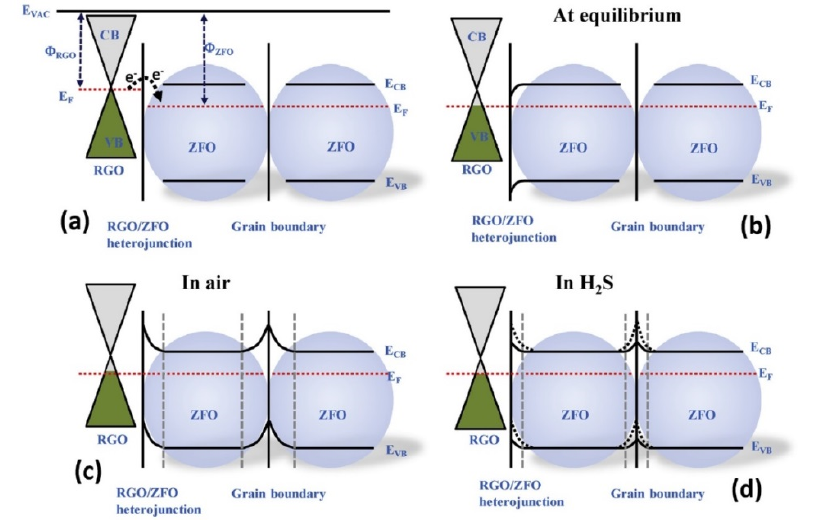
Figure 18. Band energy levels of ( a ) rGO and ZFO, ( b ) at equilibrium, ( c ) in air, and ( d ) in H 2 S gas [82].